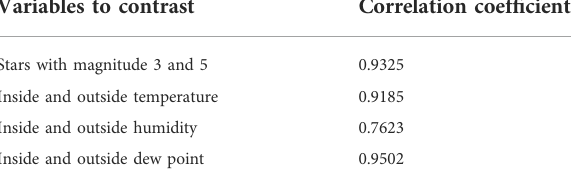
TABLE 1 Correlation between pairs of variables.